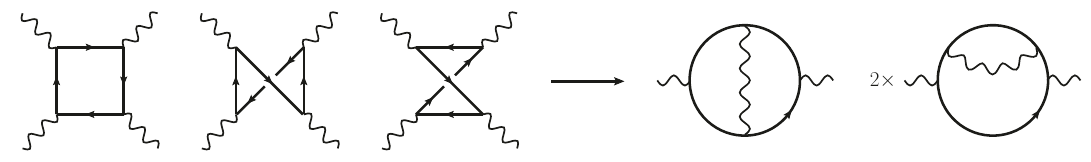
Figure 3 . One-loop LbL scattering (left three diagrams) and the resulting two-loop